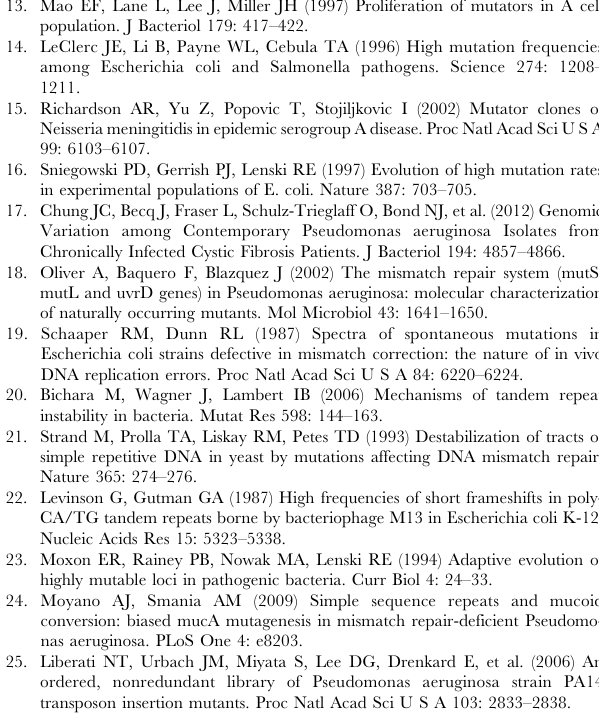
Figure S2 Mutation rates of homopolymers in intragenic and intergenic regions. Rates of mutation of homopolymers of different sizes are shown for intragenic and intergenic homopolymers, respectively. The rates are averages of the seven DK2 sub-lineages evolving with a mutS/mutL MMR-deficiency. The rates were calculated as the number of observed indels per homopolymer per mutS/mutL MMR-deficiency caused SNP (see Materials and Methods). Figure S3 Bayesian phylogenetic reconstruction and divergence date estimates of the P. aeruginosa DK2 clones. Bayesian statistics were used to estimate the divergence times of predicted ancestors. The tree is based on 7,326 unique SNPs identified from whole- genome sequencing. Circles labeled A1, A2, B1, B2, C1, and C2, respectively, denotes the position of the first and last genotype of each of the DK2 sub-lineages A, B, and C which were observed to have infected patient CF173. Figure S4 Maximum-parsimonious reconstruction of the phy- logeny of the P. aeruginoisa DK2 clones. The phylogenetic tree is based on 8,530 mutations (SNPs and indels) identified from whole- genome sequencing. Outlier isolate CF510-2006 (not shown) was used as an outgroup to root the tree. Italic letters indicate branch names, and lengths of branches are proportional to the number of mutations. The specific mutations that have accumulated during each specific branch are listed in Table S5 (SNPs) and Table S6 (indels).